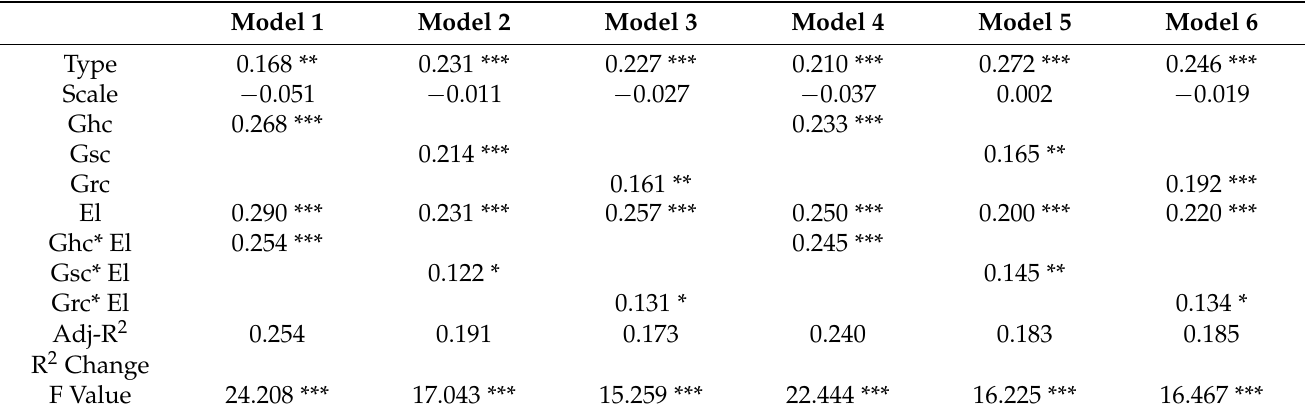
Table 5. The moderation effect of El regression results.